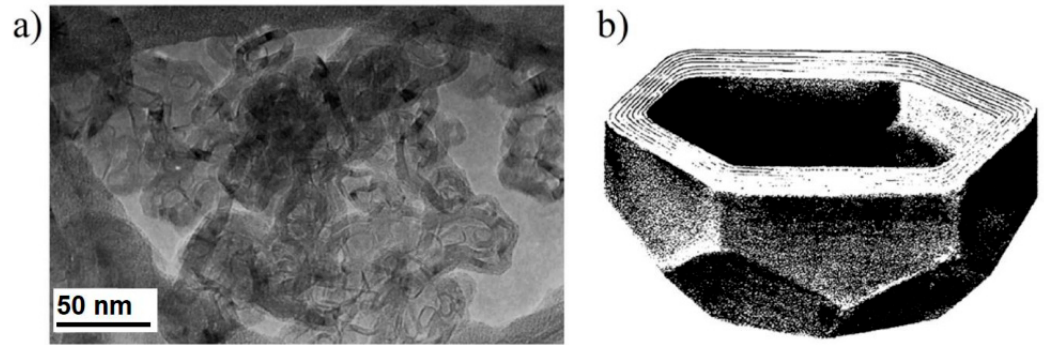
Figure 6. ( a ) Early TEM image of carbon black graphitised at 2600 °C. ( b ) Heidenreich’s model of a graphitised carbon particle. Reproduced with permission from Heidenreich et al. [36]. Copyright John Wiley and Sons, 1968.